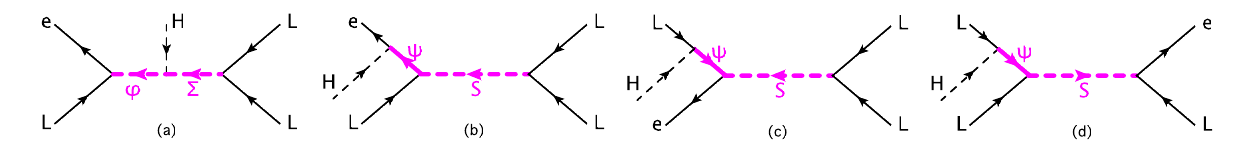
Figure 3 . Tree-level topologies for ultraviolet completion generating operator O (cid:22) eLLLH